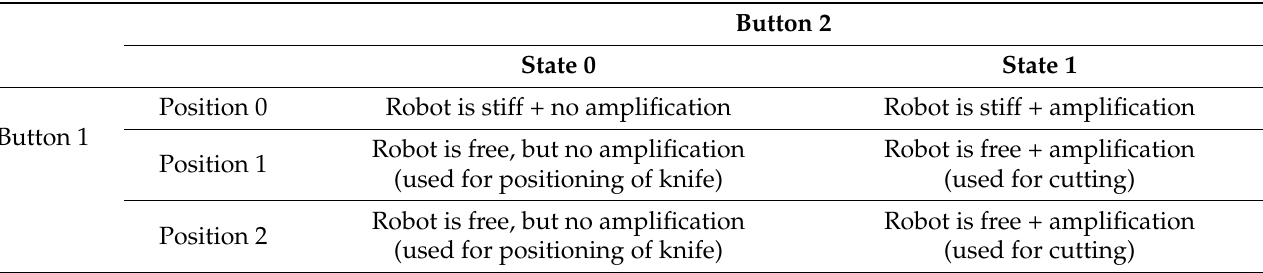
Table 4. States of joystick